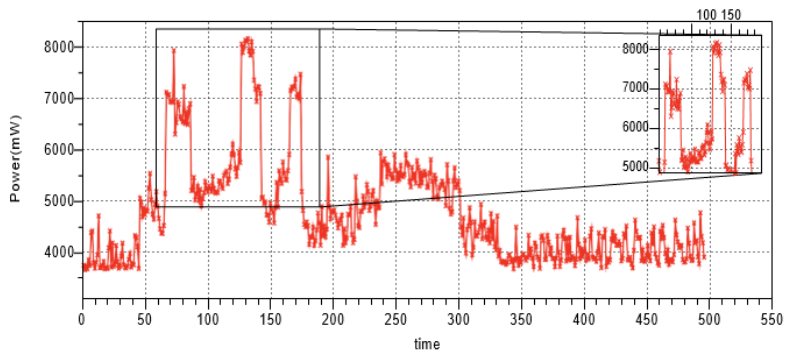
Figure 11. Odroid power consumption.